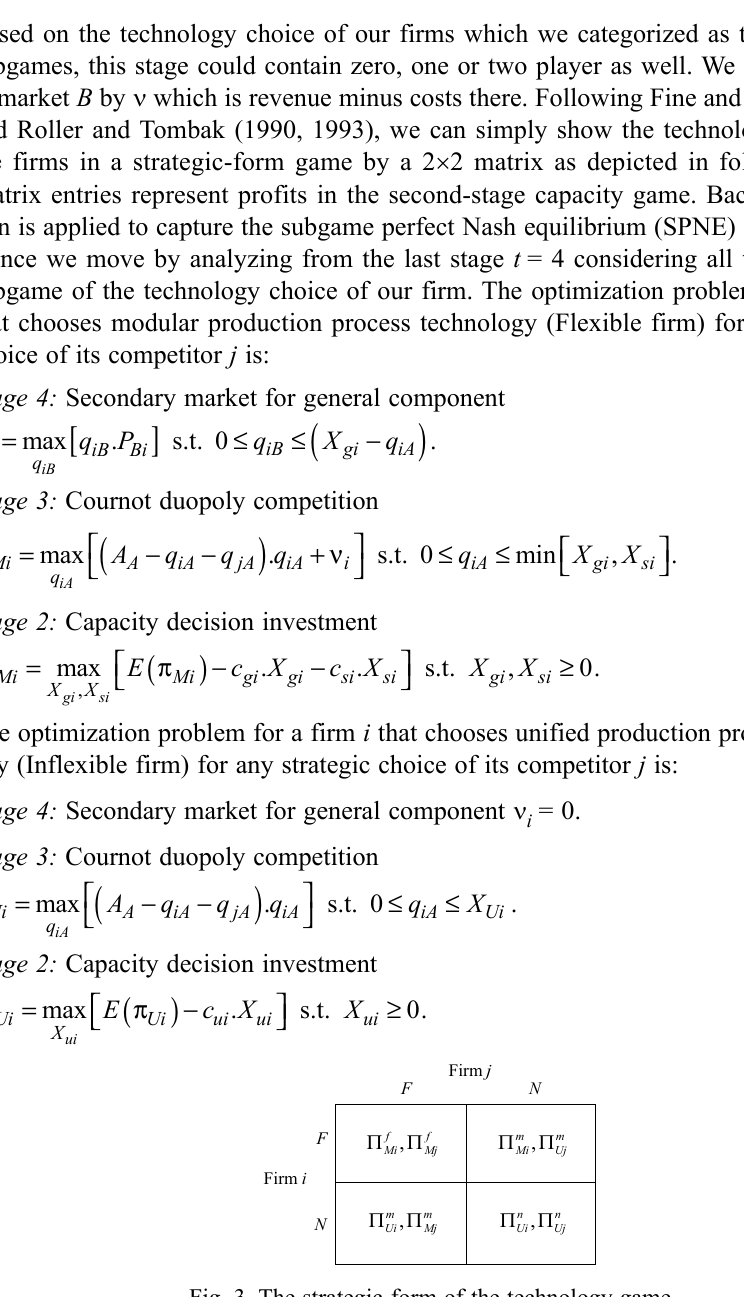
Fig. 3. The strategic-form of the technology game